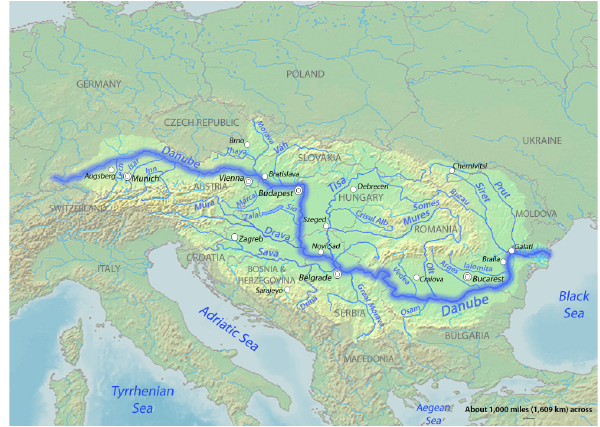
Fig. 2. Map of the Danube River Basin (http://en.wikipedia.org/ wiki/File:Danubemap.jpg).